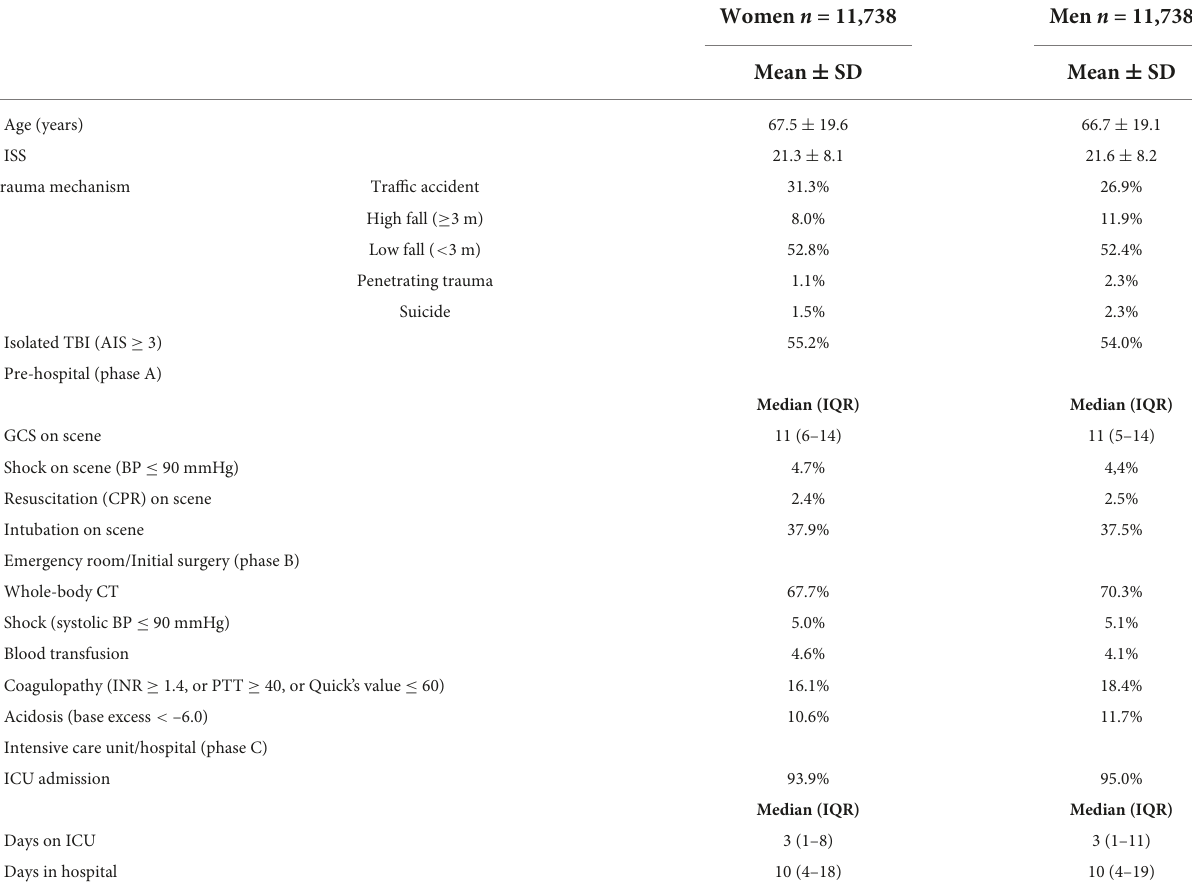
TABLE 2 Patient characteristics and specific data comparing men and